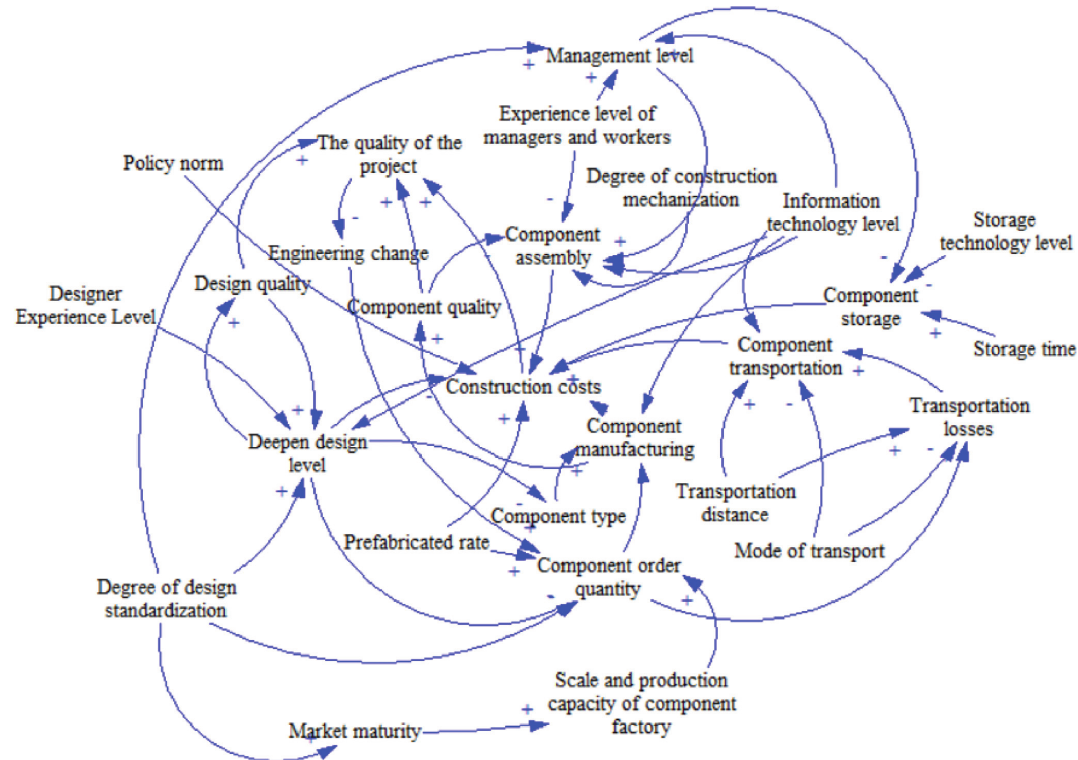
Figure 2: Cause-and-effect diagram of assembly construction